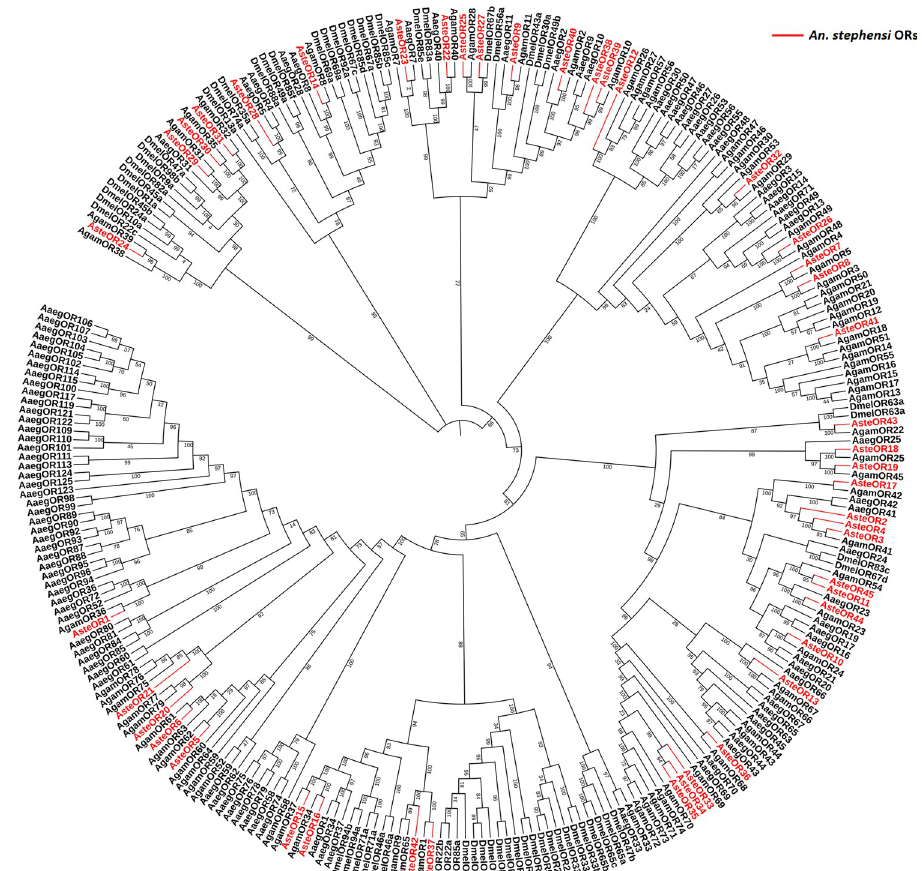
Fig 6. Phylogenetic analysis of ORs. Phylogenetic analysis of Anopheles stephensi , Anopheles gambiae , Aedes aegypti and Drosophila melanogaster ORs were carried out using FastTree 2 on galaxy web server. An . stephensi ORs showed closer relationship to An . gambiae ORs. The bootstrap values have been represented in the